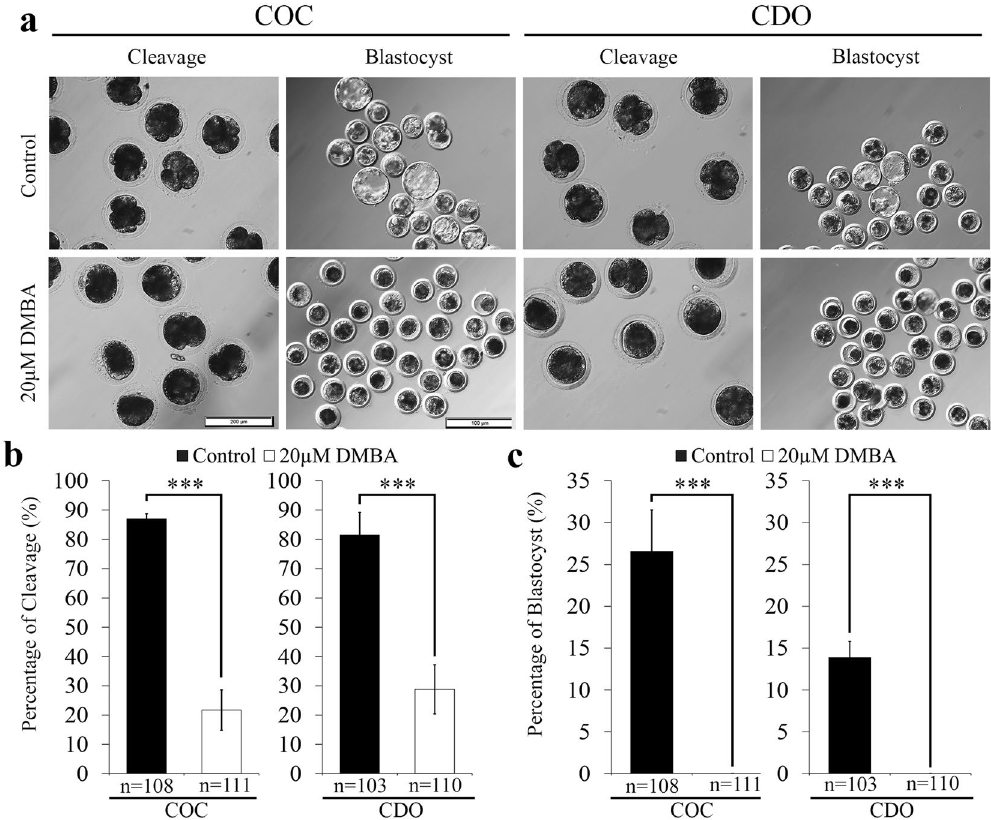
Figure 2. DMBA treatment during IVM affected developmental ability of mature oocytes. ( a ) Morphology of cleaved parthenotes (Scale bar, 200 μ m) and blastocysts (Scale bar, 500 μ m). ( b ) Percentages of cleaved parthenotes. ( c ) Percentages of parthenots developed to blastocysts. *** P <